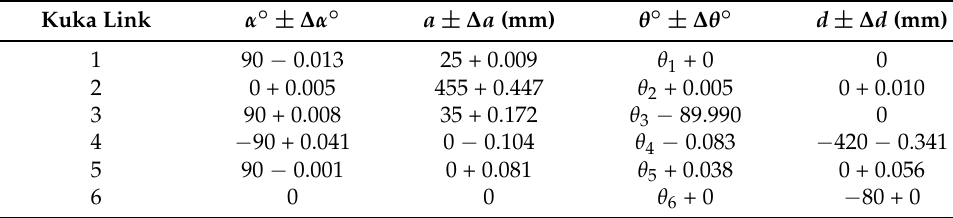
Table 2. Parameter values of KUKA robot with offset ( ∆